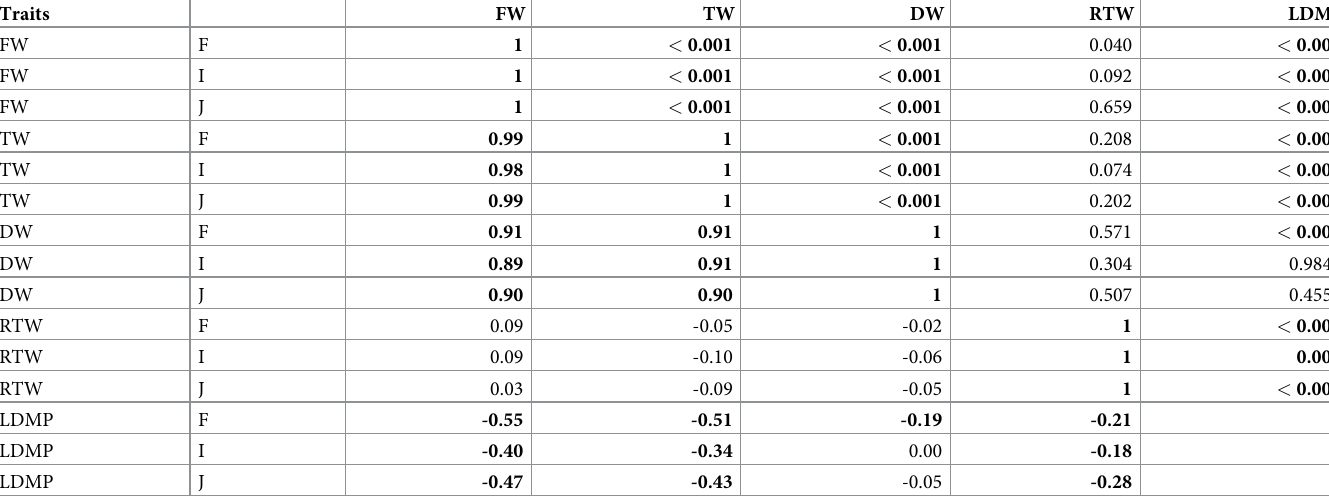
F: full panel; I: indica subpopulation; J: japonica subpopulation; FW: leaf fresh weight; TW: leaf turgid weight; DW: leaf dry weight; RTW: relative tissue weight; LDMP: leaf dry matter